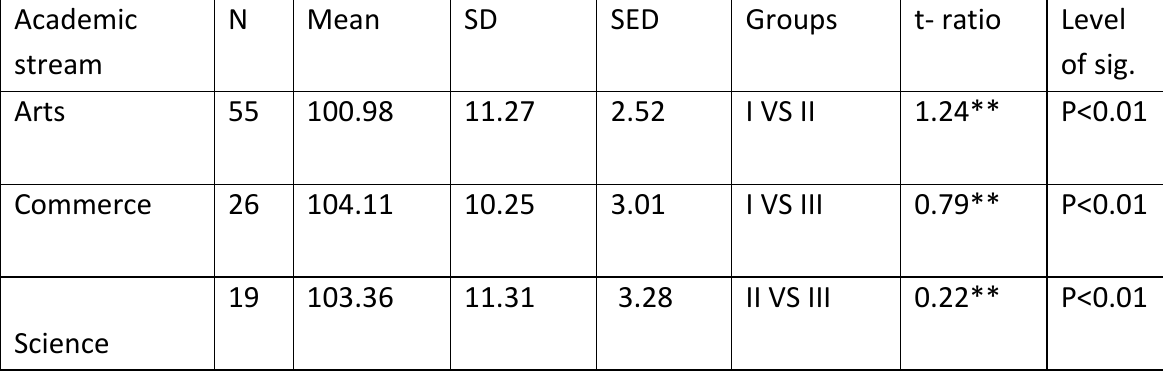
Table 1.4: Significance Difference in the Mean Scores of Arts, Commerce and